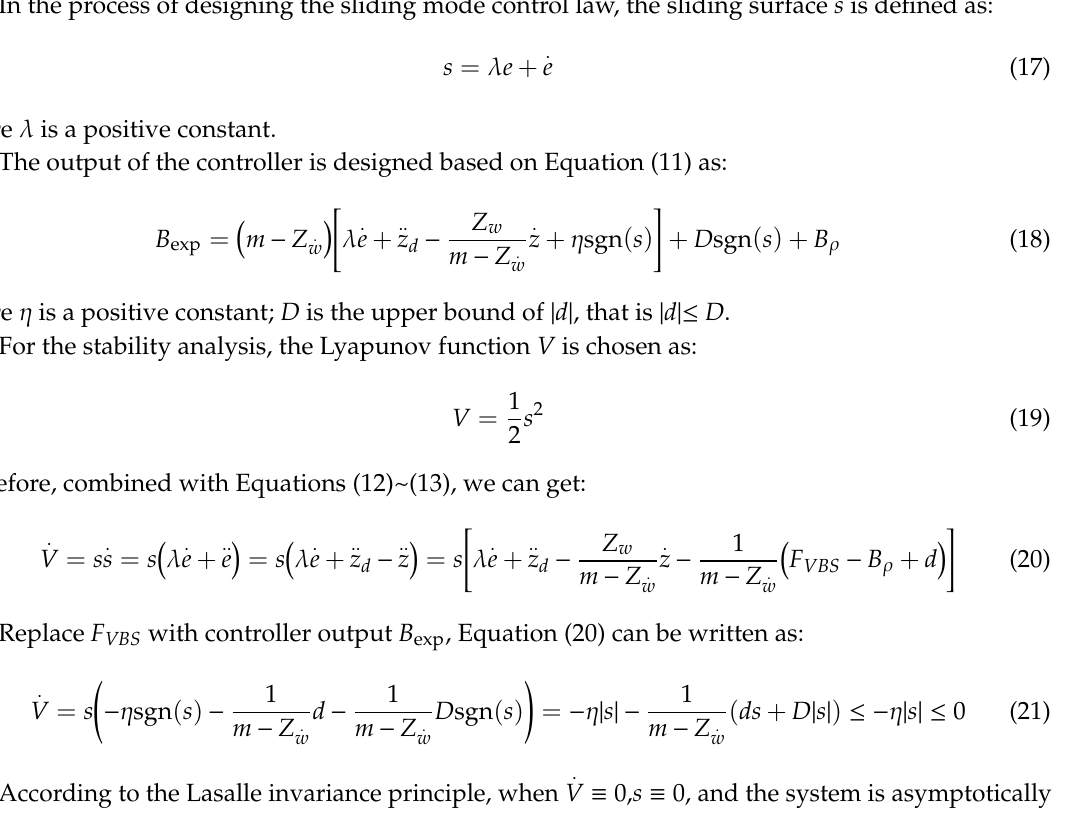
Table 4. Fuzzy control rules for (cid:52) K P , (cid:52) K I , and (cid:52) K D with inputs e · k e and / (cid:52) K / (cid:52) K (cid:52) K P I